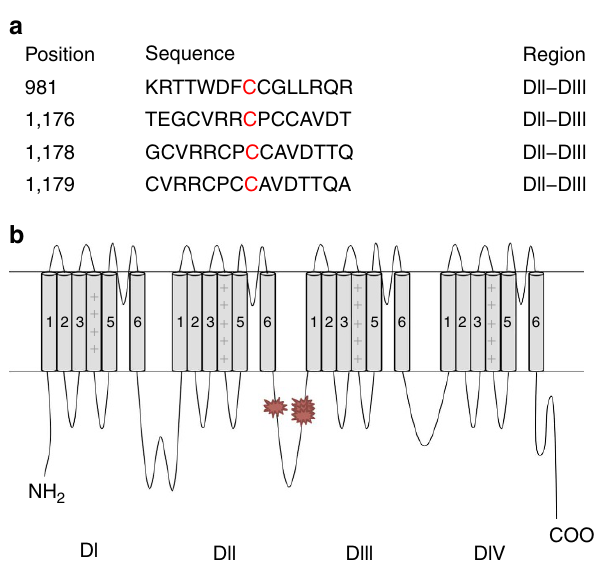
Figure 6 | Identification of palmitoylation sites using CSS-palm 3.0. ( a ) Position and sequence of the potential endogenous sites that are predicted by the bioinformatics tool CSS-palm 3.0. ( b ) Schematic view of the localization of four predicted endogenous palmitoylation sites. All four mutations are located on the domains II–III linker area.